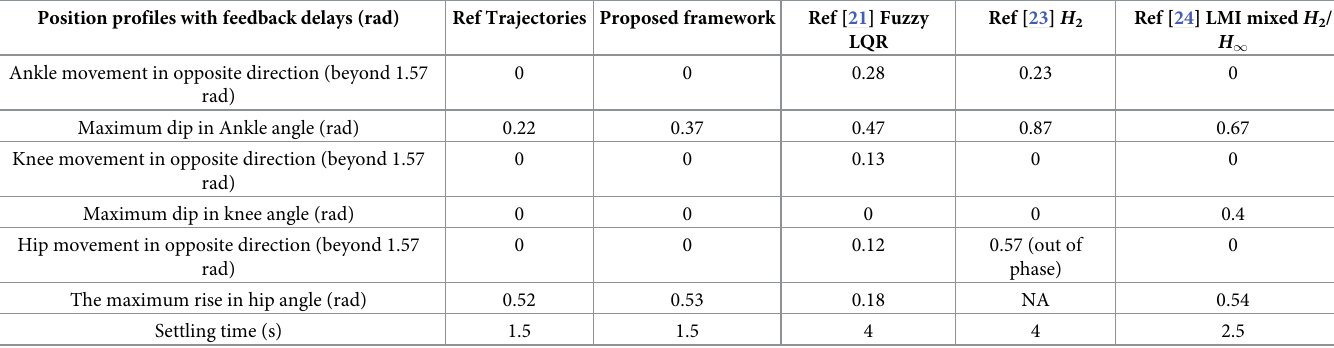
Table 3. Comparison of our simulated STS movement with earlier work in the presence of proprioceptive feedback delays. Position profiles with feedback delays (rad)